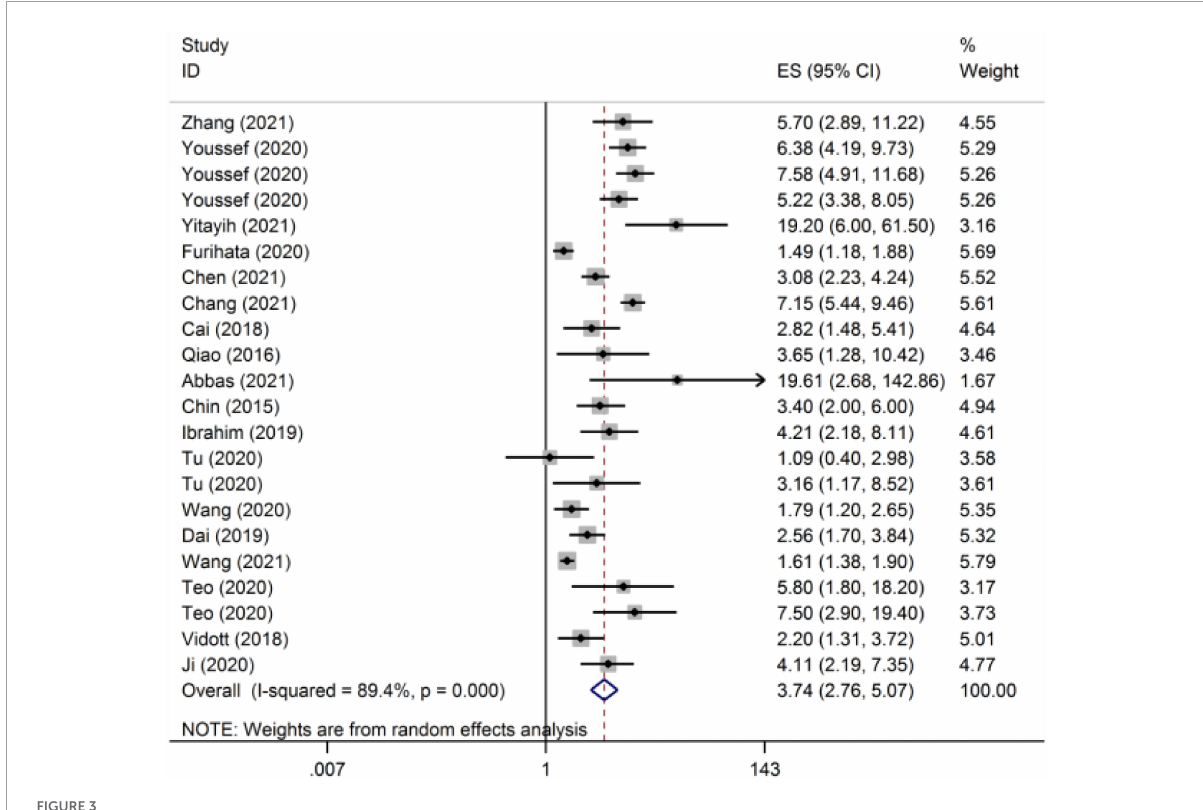
FIGURE3 The meta-analytic estimates of the odds ratio